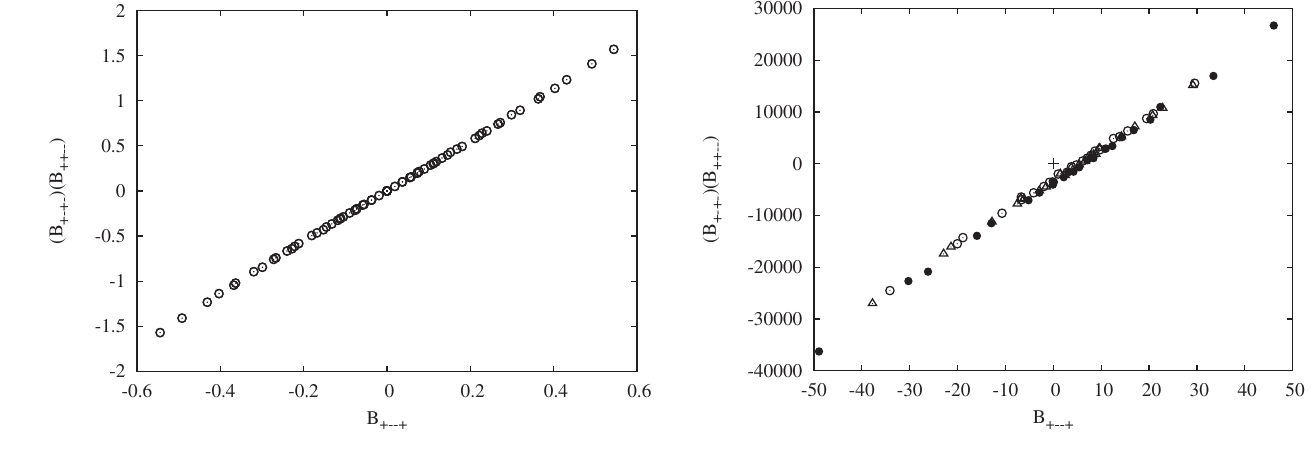
FIG. 6. B þ(cid:3)þ(cid:3) B þþ(cid:3)(cid:3) vs B þ(cid:3)(cid:3)þ for measurements of CESR BPM (#21E). There are 75 measurements distributed on a grid. The þ indicates the coordinate (0,0).